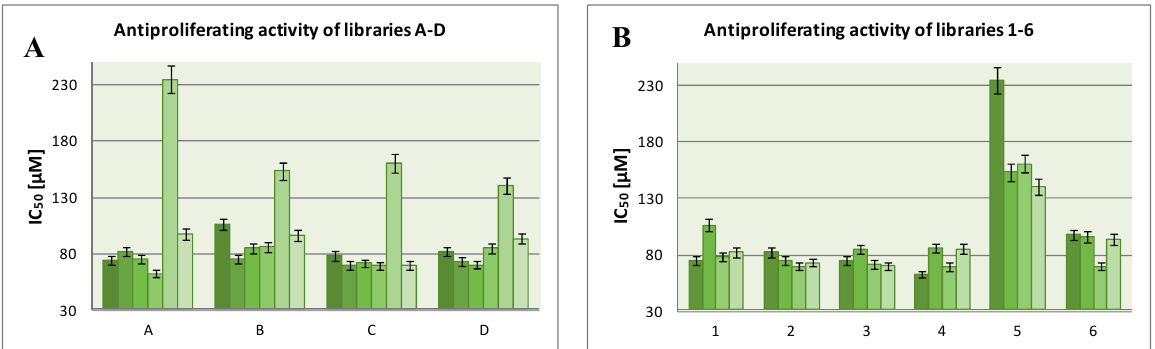
Figure 4. The IC values of libraries A – D ( A ) and 1 – 6 ( B 50